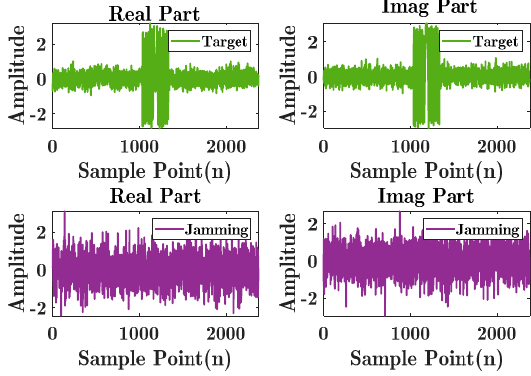
Figure 5. Waveforms of separated signals.